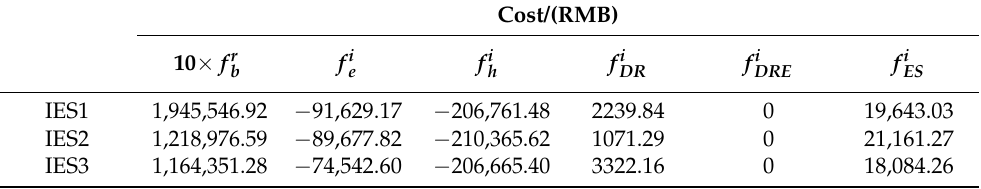
Table 14. Case 6 results.